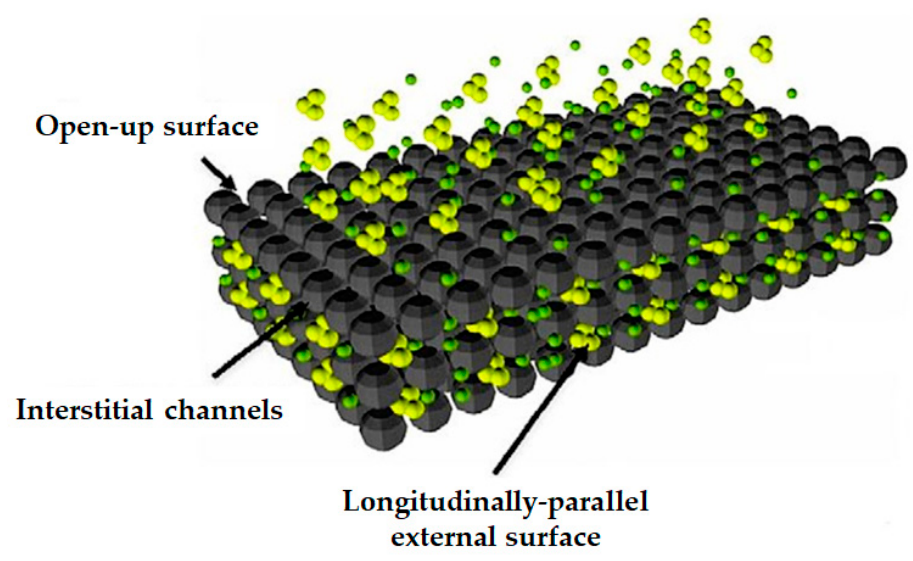
Figure 3. Graphical representation of structure and absorption sites of graphene sheets (Reproduced with permission from [65]).